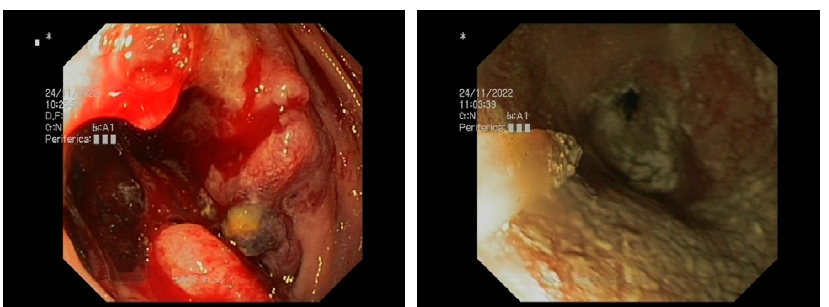
Figure 3. Pancreatic cancer invading duodenum.